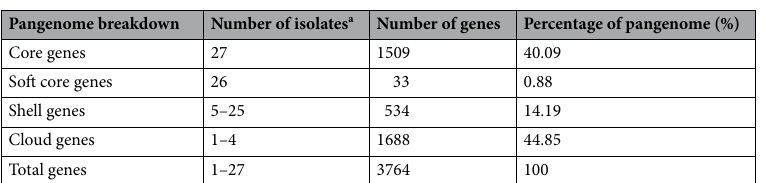
Table 2. Pangenome analysis results. The total number of genes and percent of total pangenome is shown. a Number of isolates out of the total ( n =